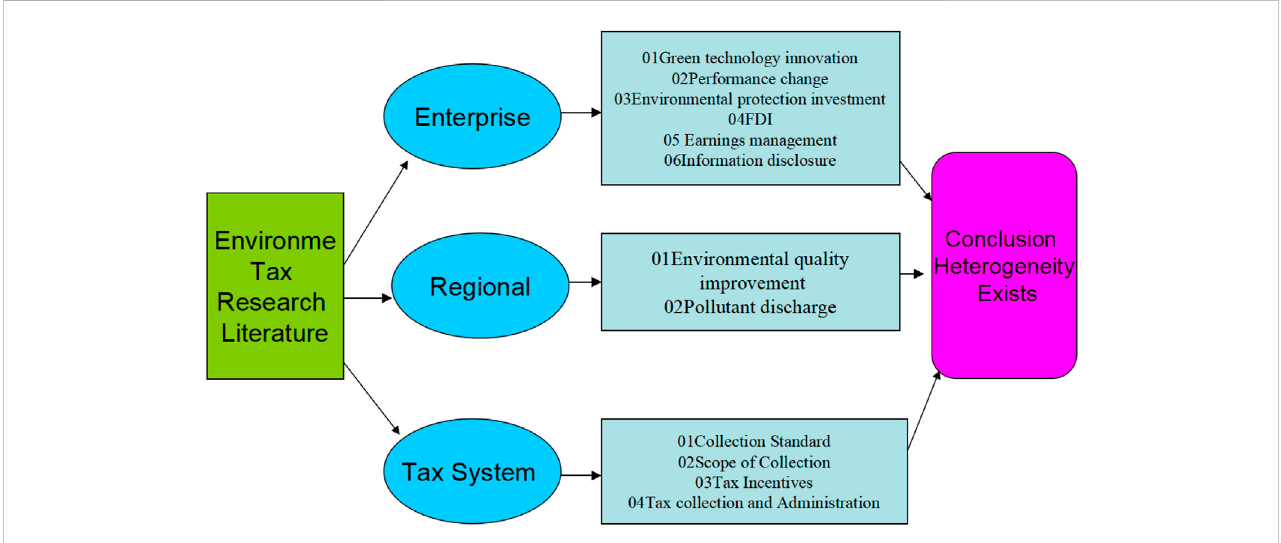
FIGURE 1 Literature analysis of research results of environmental protection